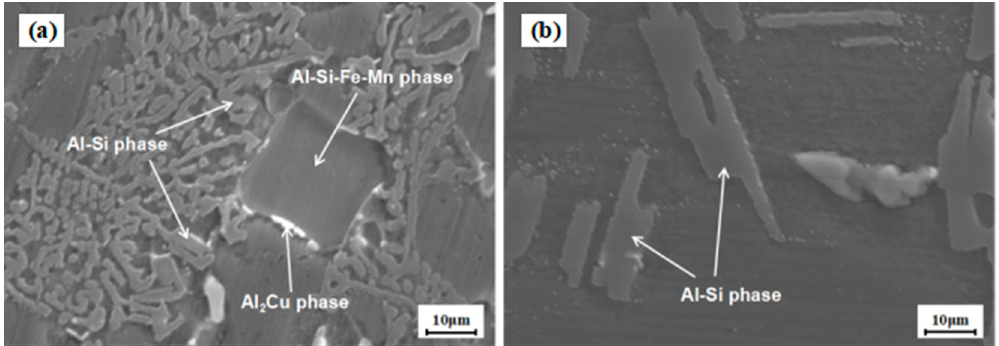
Figure 6. SEM images of different areas of the casting: ( a ) thin-walled area, ( b ) thick-walled